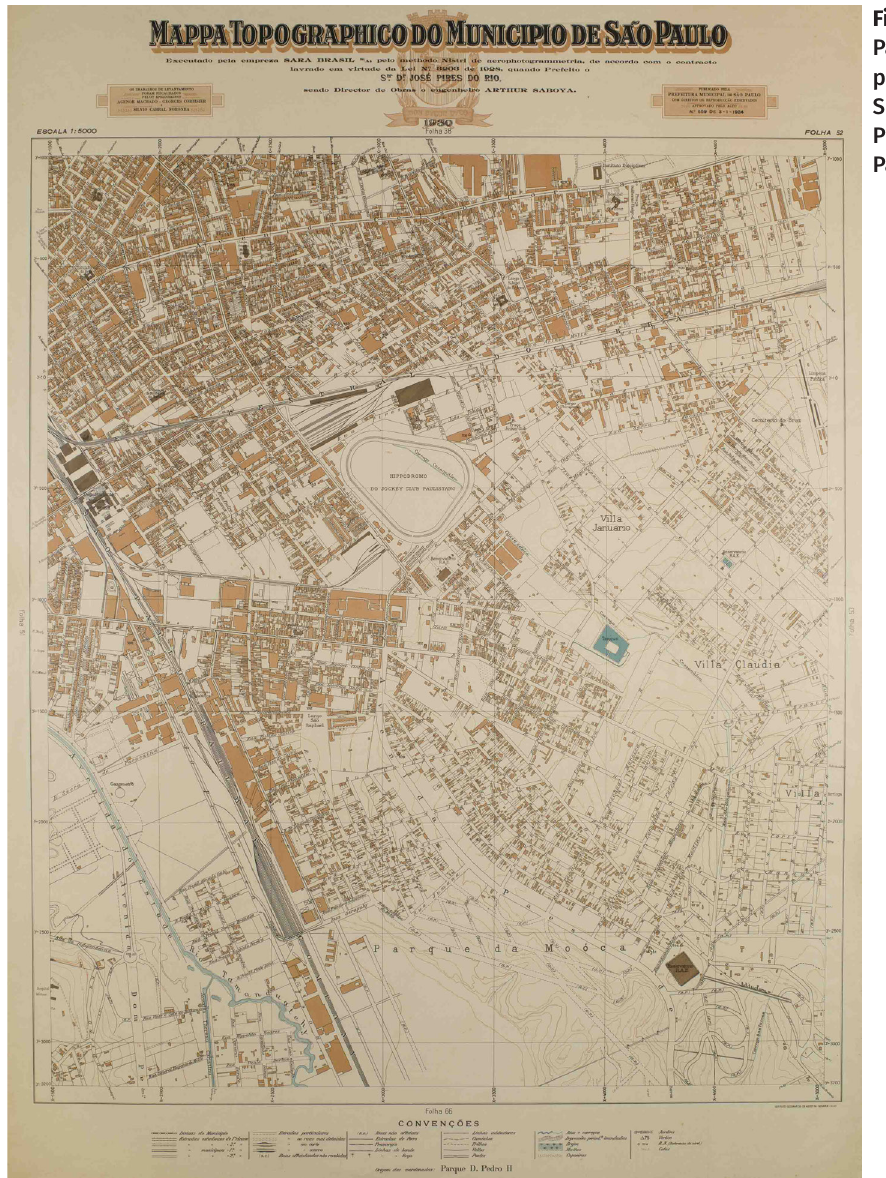
Figure 5. Map of São Paulo based on aero photogrammetry (1930). Source: Museu Paulista. Paulista (USP)